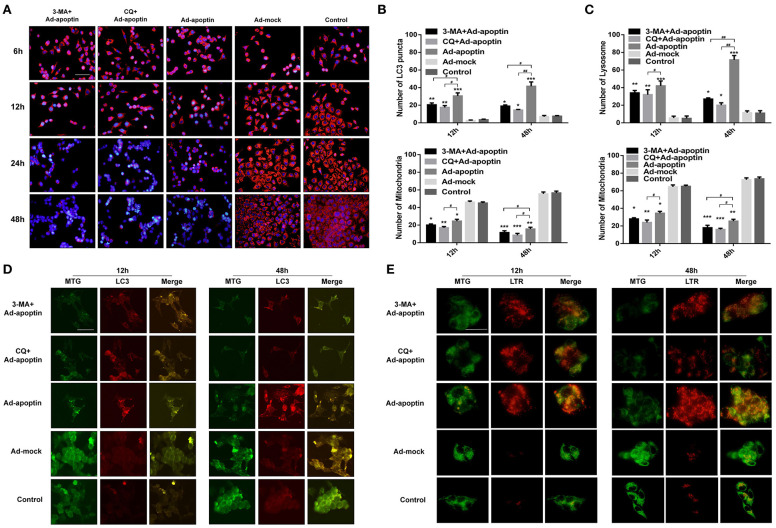
Relationship between autophagy and mitochondria in apoptin-induced SMMC-7721 cells. (A) Changes in mitochondrial membrane potential (MMP) observed by fluorescence microscopy, after TMRM and Hoechst staining. SMMC-7721 cells were infected with Ad-apoptin and treated (or not) with the autophagy inhibitor 3-MA and CQ. Cells were further stained with TMRM and Hoechst at 6, 12, 24, and 48 h. Apoptin increases the level of apoptosis of cells and reduces the level of MMP; the addition of 3-MA and CQ will cause a significant increase in the level of apoptosis and a significant decrease in the level of MMP. (B,D) MTG and LC3 staining analysis in Ad-apoptin-infected SMMC-7721 cells. Concomitant increase of red fluorescence and the decrease of green fluorescence appears to be caused by apoptin. Upon treatment with 3-MA and CQ, the mitochondrial green fluorescence decreased faster than the LC3 red fluorescence. The bright spots of mitochondria and LC3 are in the same place. At the same time, evaluated the changes of average number of LC3 puncta and mitochondria in each cell. (C,E) MTG and LTR staining analysis in Ad-apoptin-infected SMMC-7721 cells. Concomitant increase of red fluorescence and the decrease of green fluorescence appears to be caused by apoptin. Upon treatment with CQ, the mitochondrial green fluorescence decreased faster than the lysosomal red fluorescence. The increase of red fluorescence and the decrease of green fluorescence occurred at same location within the cells. At the same time, evaluated the changes of average number of lysosome and mitochondria in each cell. The scale bar equals 100 μm. Data are shown as mean ± SD (*p < 0.05, **p < 0.01, ***p < 0.001) when compared with controls. Data are shown as mean ± SD (#p < 0.05, ##p < 0.01) when compared with Ad-apoptin.